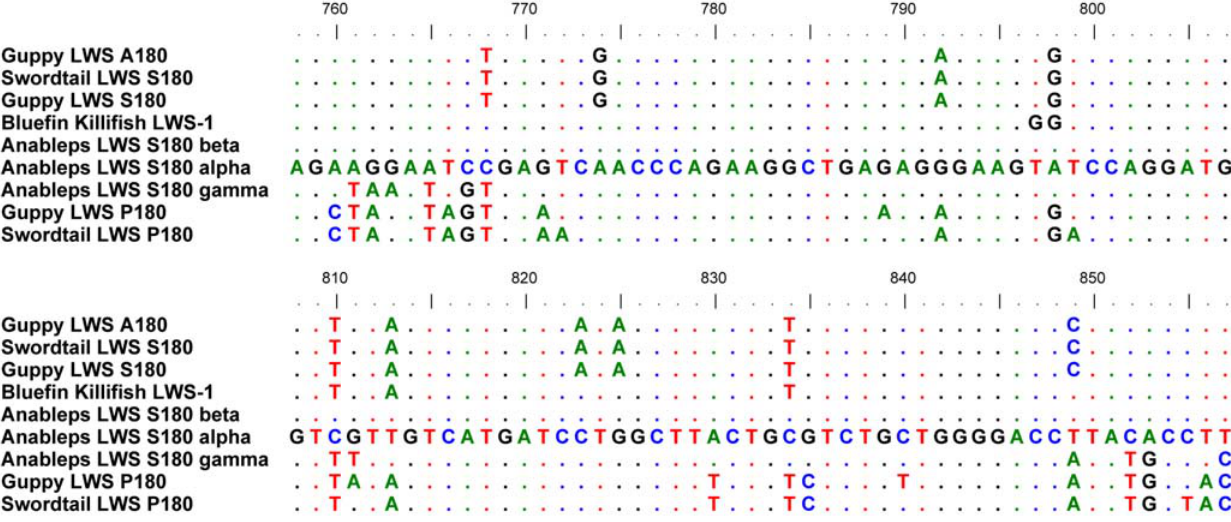
Figure 2. Sequence comparison between LWS genes. An alignment of 100 bp region of interest between between A. anableps LWS S180 a and LWS S180 c . Over this area, A. anableps LWS S180 c is more similar to poeciliid P180, than to other A. anableps sequences.